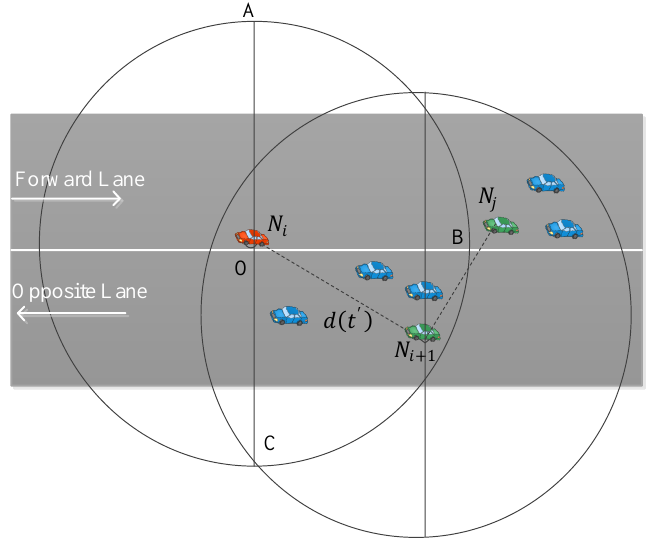
Figure 4. Selection of a vehicle in opposite lane.